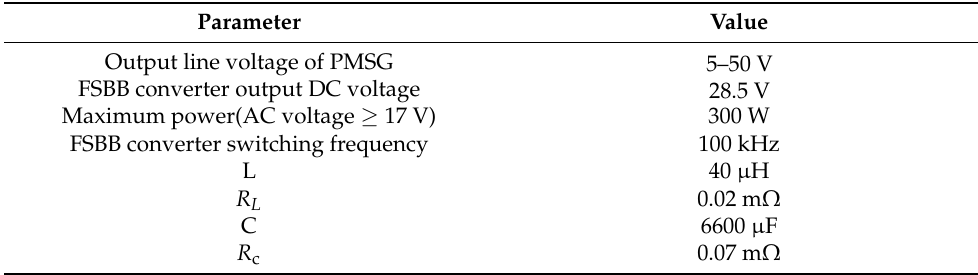
Table 1. Parameters of the AC-DC